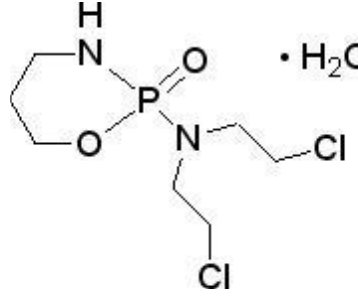
Figure 2. The chemical structure of